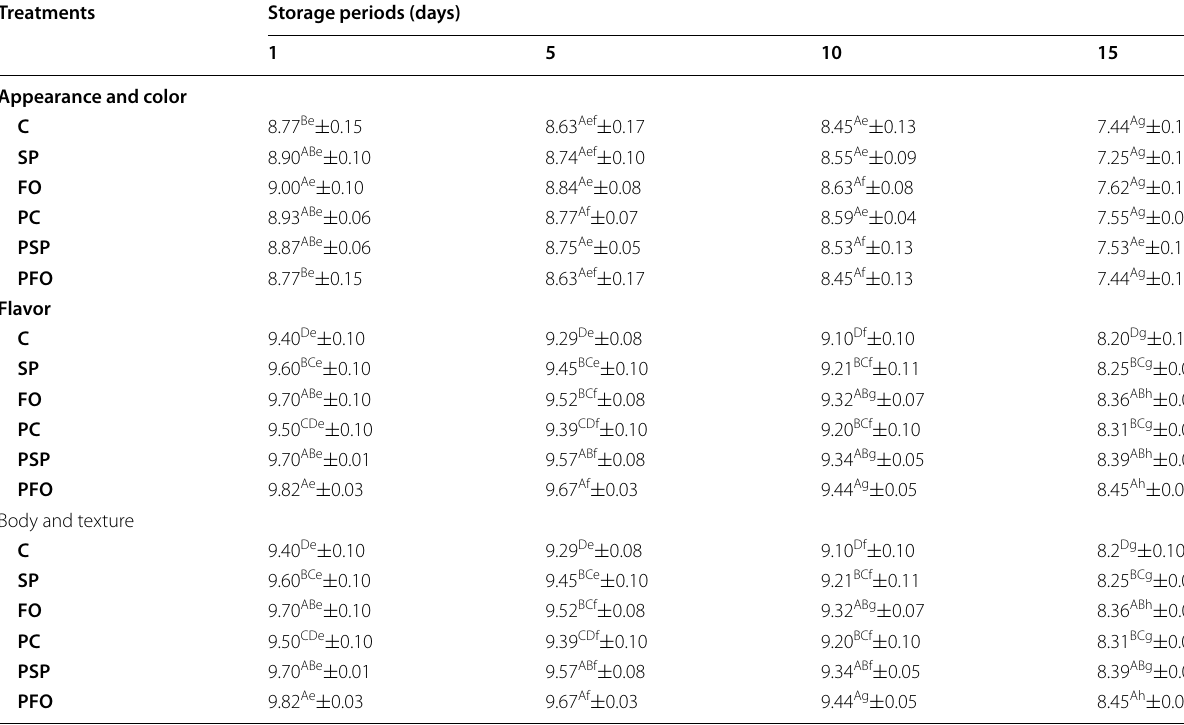
Table 6 Sensory evaluation of probiotic and non‑probiotic yoghurt made from ewes’ milk fed a diet supplemented with Spirulina platensis or fish oil during storage at 5 2 °C for 15 days ±